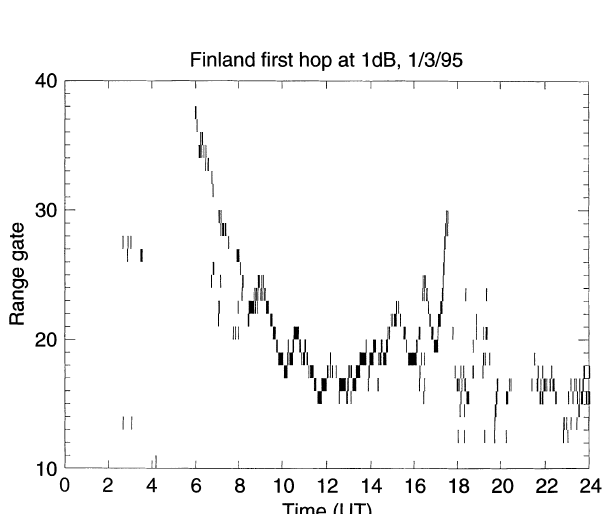
Fig. 6. Band-pass filtered electron den- sity perturbations as a function of height and time from the EISCAT radar on 1 March 1995. The units are 10 10 m ) 3